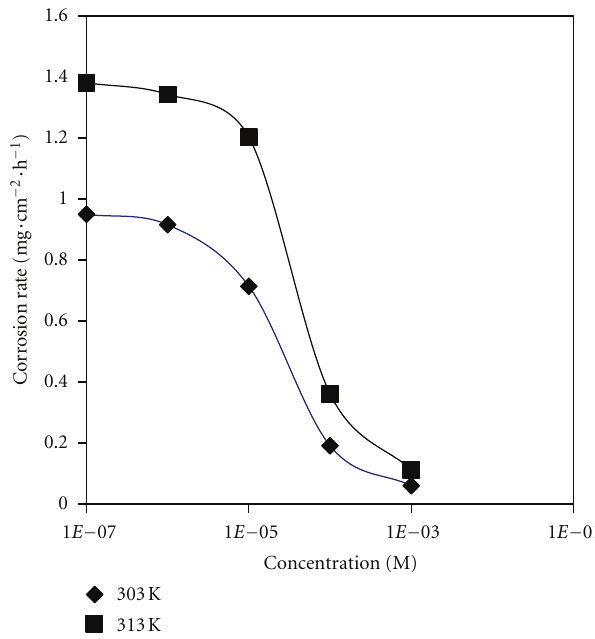
Figure 1: E ff ect of concentration of trans-4-hydroxy-4 (cid:2) -stilbazole on the corrosion rate (mg · cm − 2 · h − 1 ) of mild steel in 1M HCl at various temperatures.